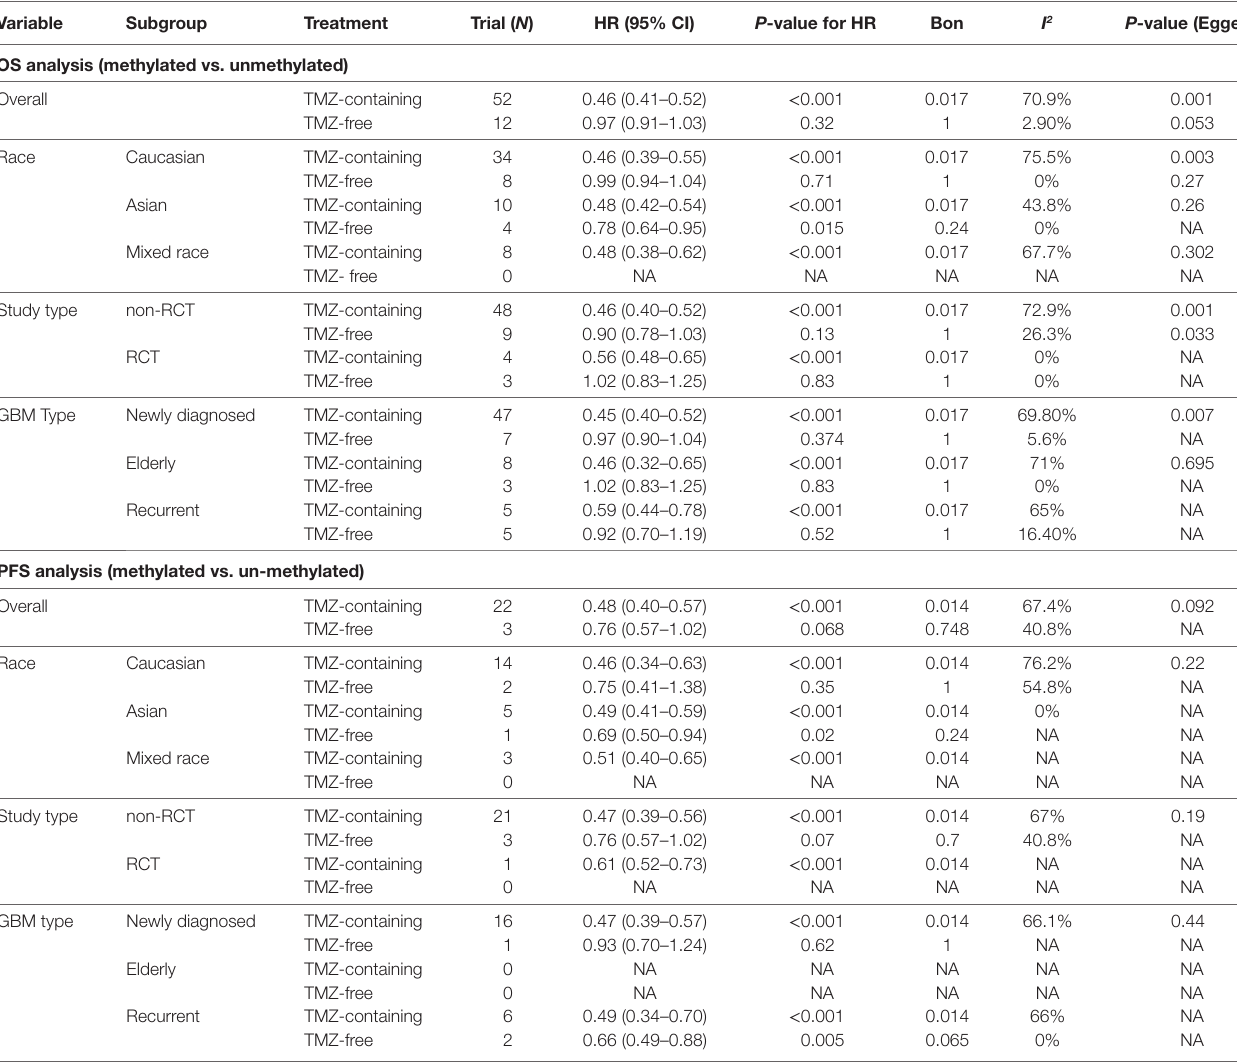
taBLe 2 | Summary of subgroup